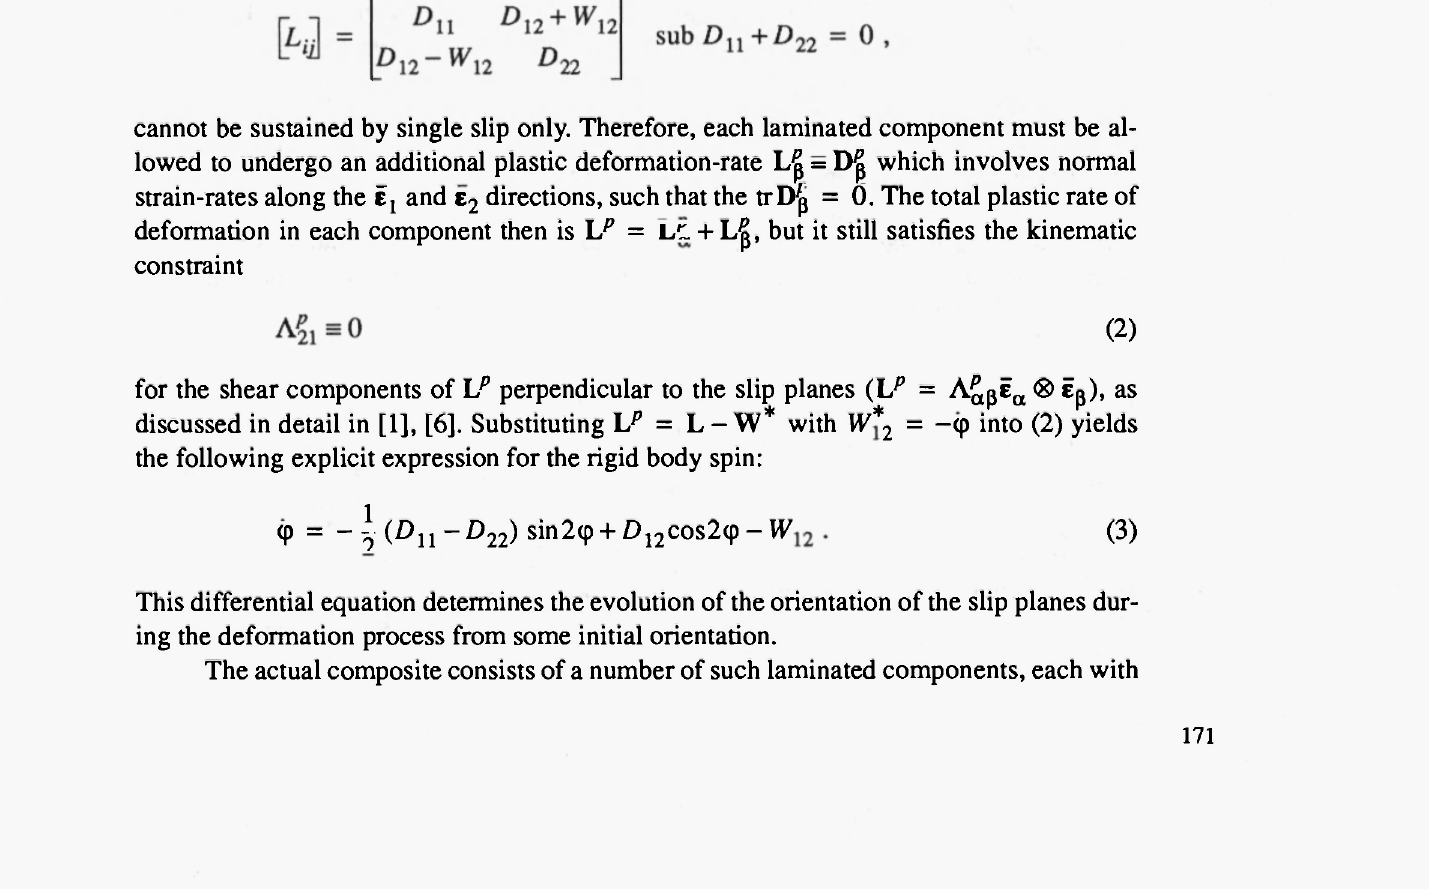
slip is given by the well-known expression V a = ' fb <8> η (cf. e.g. [4], [10]), with the slip direcion and slip plane normal being given by b = η = ε 2 , respectively. However,